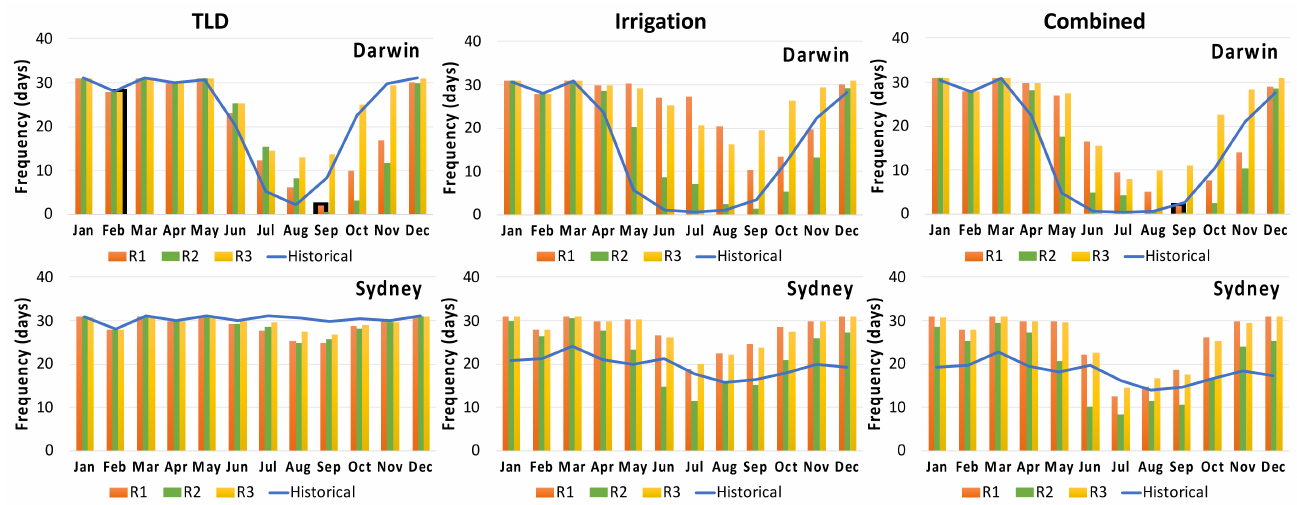
Figure 12. Charts showing number of days when monthly water demand is met for 5 m 3 rainwater tank for TLD, irrigation and combined